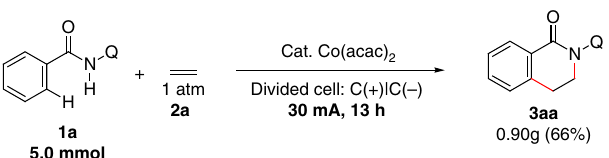
Fig. 1 Large-scale synthesis. Gram scale reaction with ethylene under electrochemical conditions